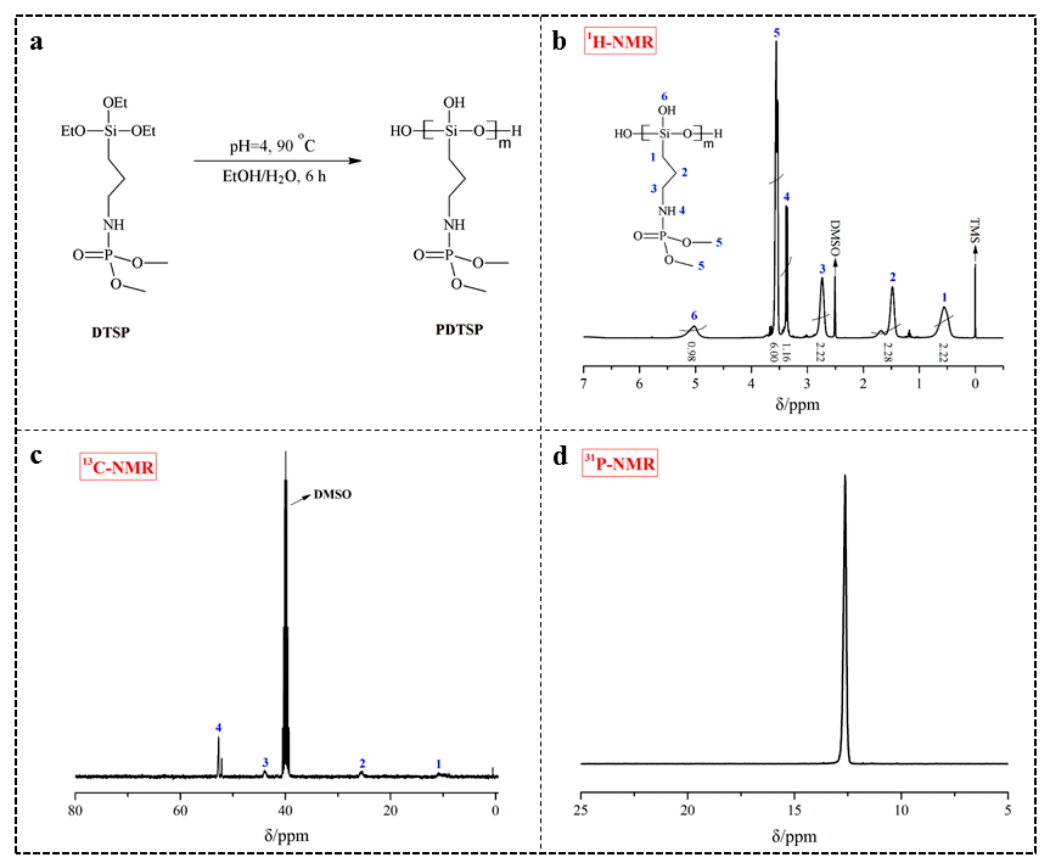
Figure 1. Synthesis route ( a ), 1 H-NMR ( b ), 13 C-NMR ( c ), and 31 P-NMR ( d ) spectra of PDTSP.